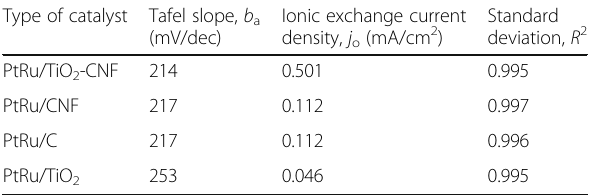
Table 6 Data extraction from the Tafel